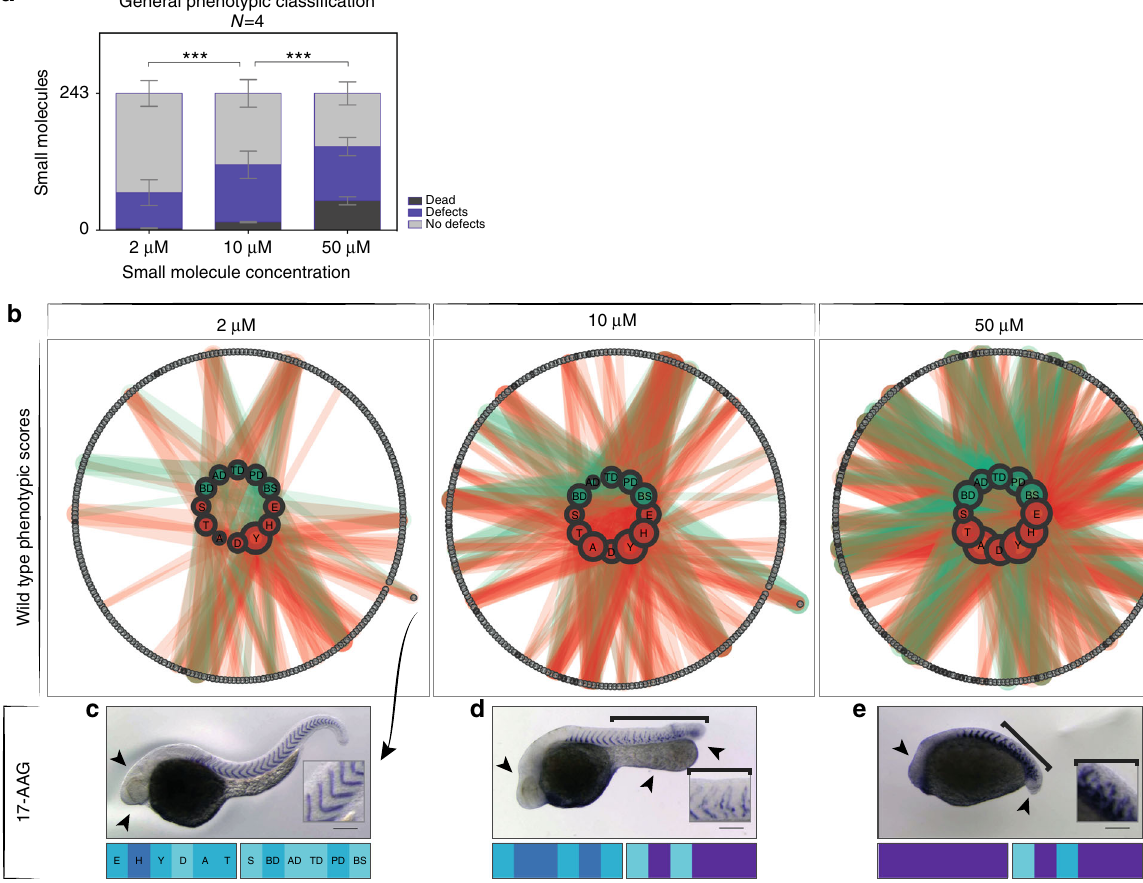
Fig. 3 Concentration dependence of phenotype. a Plot showing the number of lethal treatments, treatments showing at least one defect (any parameter > 0), or no defects depending on the concentration as a mean ( ± SD) of four independent experiments (2 wild type replicates, 2 mutant genotypes). Lethal conditions signi fi cantly increased with increasing concentration (2-way ANOVA, P < 0.0001). b Wild type_A phenotypic scores across the concentration series illustrated as interaction networks. Inner circles represent phenotypic parameters: morphology in green, segmentation in red. Size of nodes represents the frequency of scoring > 0 for each individual parameter. Interactions to outer circle represent the link of phenotypic parameter to given small molecule (gray circles). Thickness of interaction lines gives magnitude of score. Dark gray circles, lethal treatments. Small molecule names corresponding to numbers can be found in Supplementary Table 1. Small molecule highlighted in outer circle across concentration series is 17-AAG. Representative images shown in c – e . c 2 µ M 17-AAG, normal segmentation (inset), mild defects of head (arrowheads) and yolk extension. d 10 µ M, defects of the head morphology (arrowhead) and thickened yolk extension (arrowheads), truncated axis and disrupted myotome boundaries posterior to the 8th (bracket). e 50 µ M, 17-AAG, strong developmental defects (arrowheads) and disrupted segmentation (bracket, inset). Corresponding phenotypic vector fi ngerprints below each image show increasing scores for almost all parameters with increasing concentration. Scale bar: 200